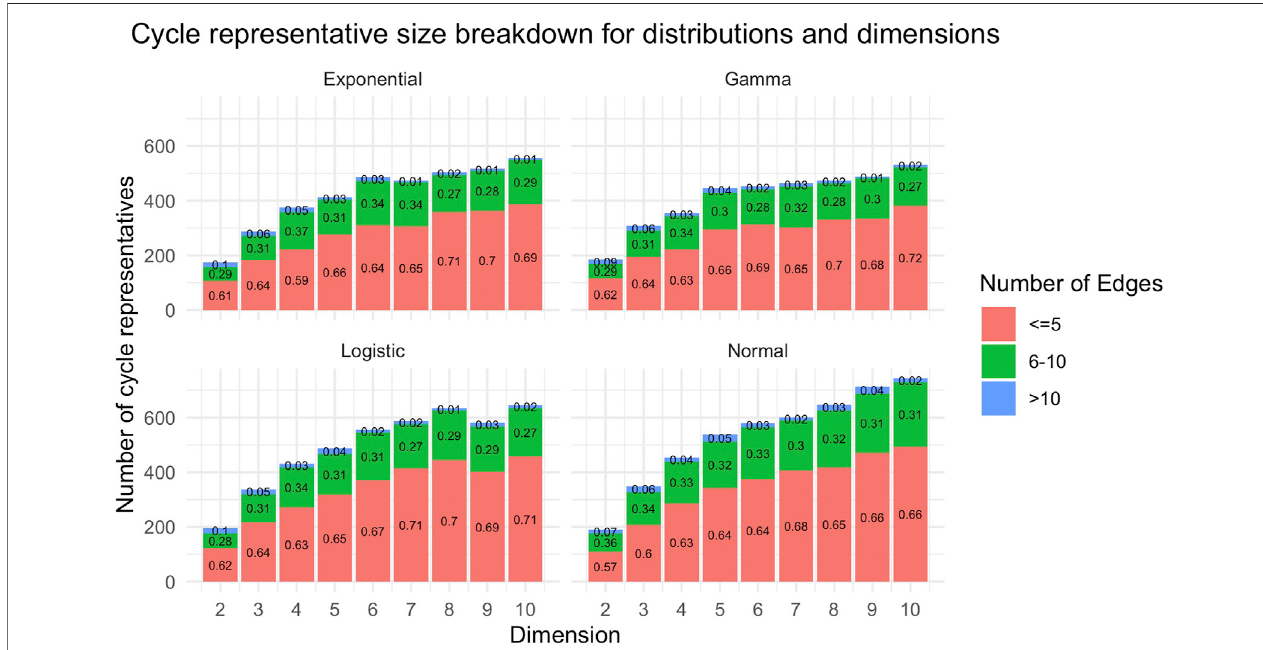
FIGURE 13 | The number oforiginalcyclerepresentatives and the numberofedges withineachoriginalrepresentativefor datadescribed in Section5.2 . These plots aggregateallcycle representativesfor eachdimension ofaparticulardistribution. The horizontalaxisfor eachsubplotisthedimensionofthedataset,and theverticalaxisis thenumberofcyclerepresentativesfoundineachdimension.Ingeneral,weseetherearemorecyclerepresentativesinhigherdimensionaldatasets.Eachbarispartitioned by the number of edges of the representative. We observe that as dimension increases, there tend to be more cycle representatives with more